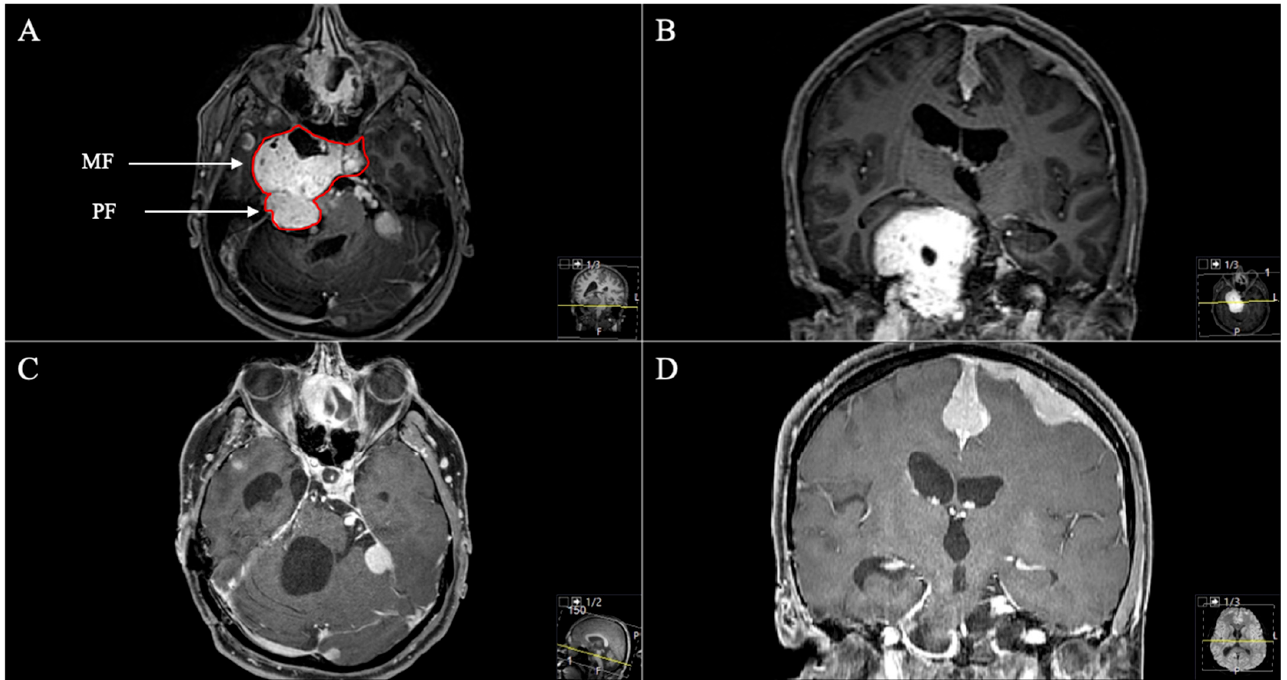
Figure 4. A 39-year-old male patient with neurofibromatosis type 2 presented with progressive vertigo, intermittent right facial pain and trigeminal hypesthesia (V1). ( A ) Preoperative axial and ( B ) coronal T1-weighted gadolinium-enhanced MRI, showing an impressive space-occupying cystic trigeminal schwannoma, involving the middle (MF) and posterior fossa (PF) through Meckel’s cave (Samii Type C). ( C ) Postoperative axial and ( D ) coronal MRI control, indicating complete resection via a two-stage technique; a modified Kawase and a retrosigmoid approach were performed. Postoperatively, no new deficits occurred and the patient recovered from the facial pain.